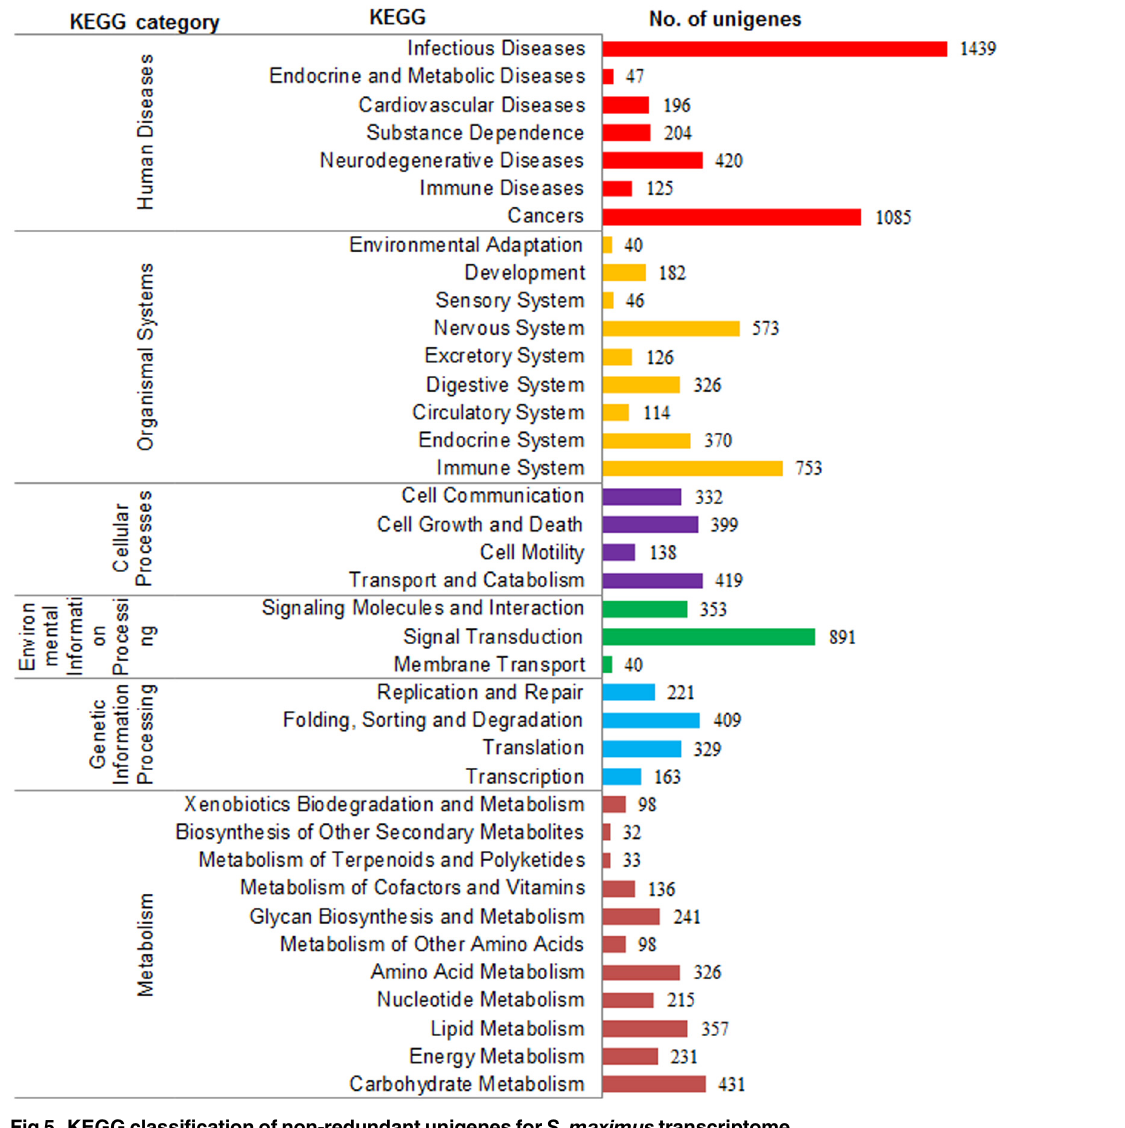
Fig 5. KEGG classification of non-redundant unigenes for S . maximus